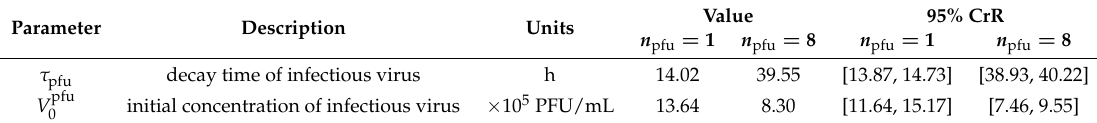
Table 3. Parameter values obtained from fitting Equations (2) to viral titer data. The 95% credible regions (CrRs) were constructed from MCMC fits of the model (2) to